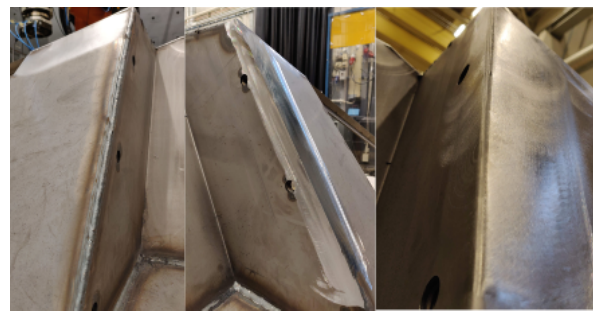
cal movements with angle grinder to remove all excessive material from the seam. Objective of this phase is to re- sult a sharp-pointed seam without any extra material left from welding. In the second phase, the seam will then be rounded by using a sander. Both phases will use the same four input targets to form the grinding programs. Results can be seen in Figure 13.